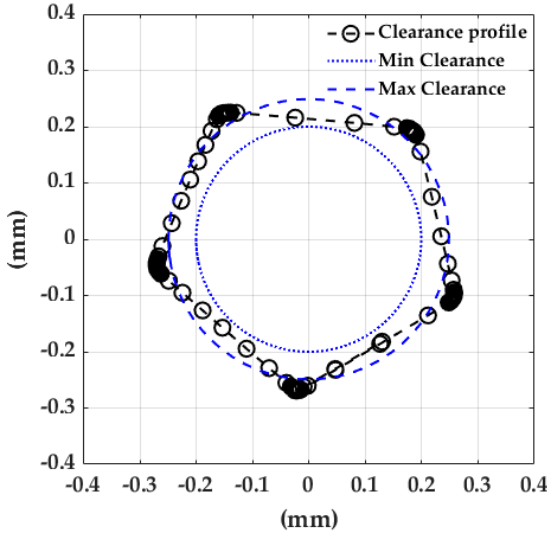
Figure 10. Direct Lube Bearing clearance profile from the bump test.